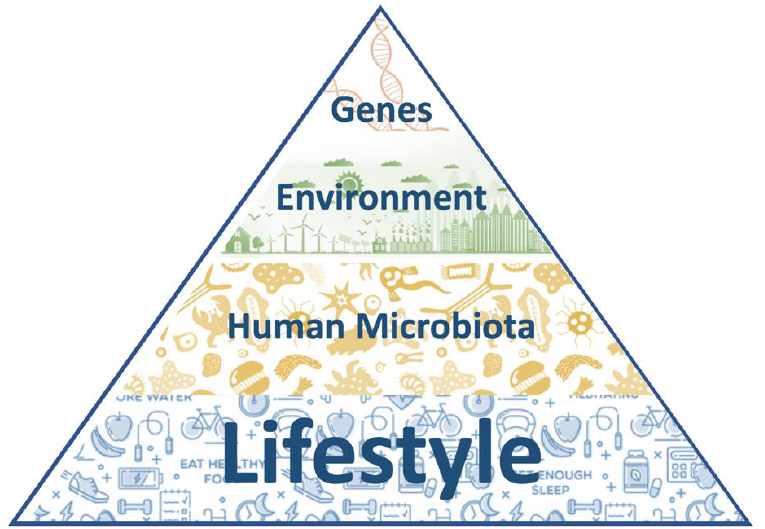
Figure 1. The nature and nurture pyramid. At the base of the pyramid there are the most modifiable factors (lifestyle habits and the microbiota composition), while the less modifiable ones rise towards the apex (environmental factors and the individual genetic background).